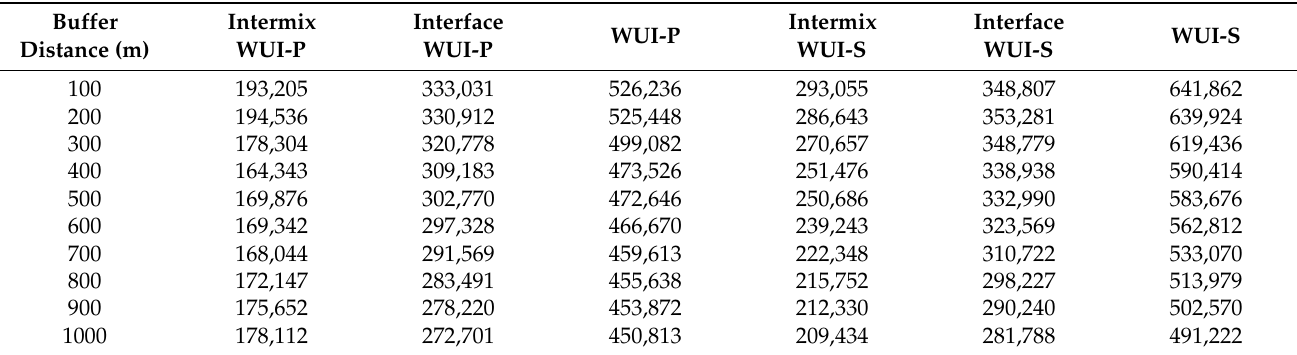
Table 3. The number of structures within WUI-P and